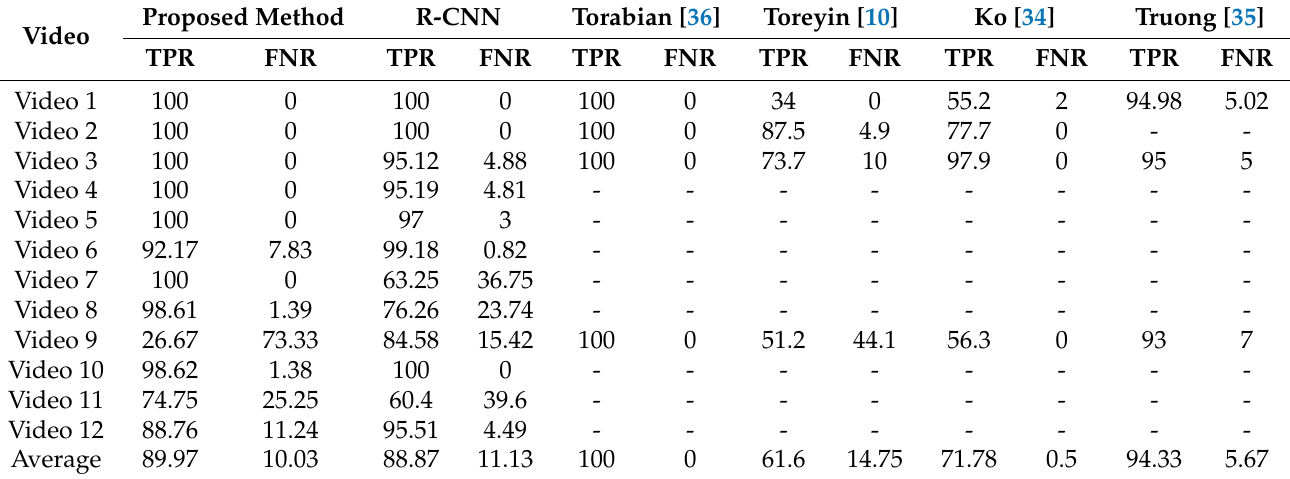
Table 5. Comparison of TPR and FNR Results (in percentage) on VisiFire Dataset [32].